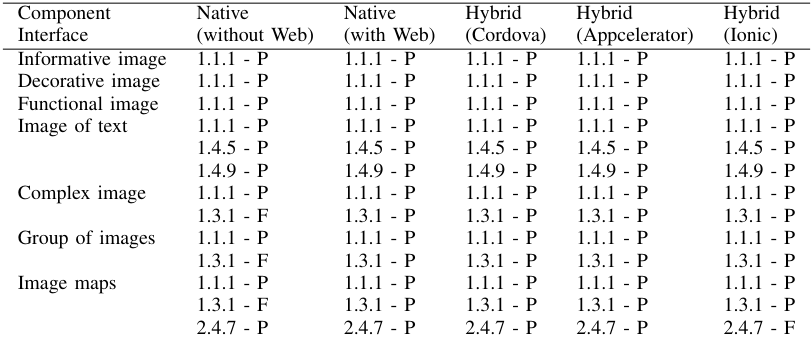
TABLE II A CCESSIBILITY INSPECTION OF IMAGE COMPONENTS